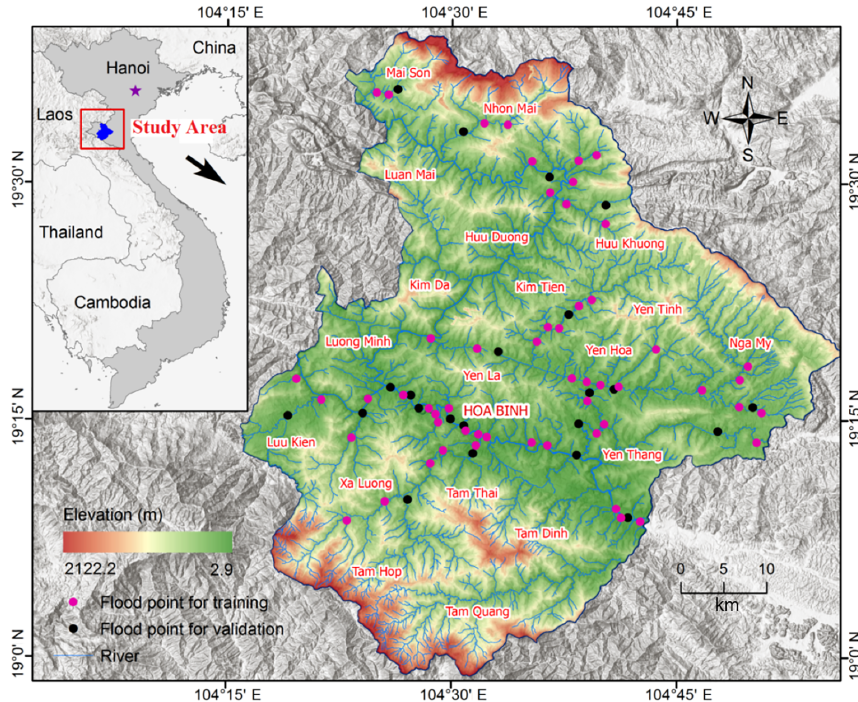
Figure 1. Location of the Tuong Duong district (central